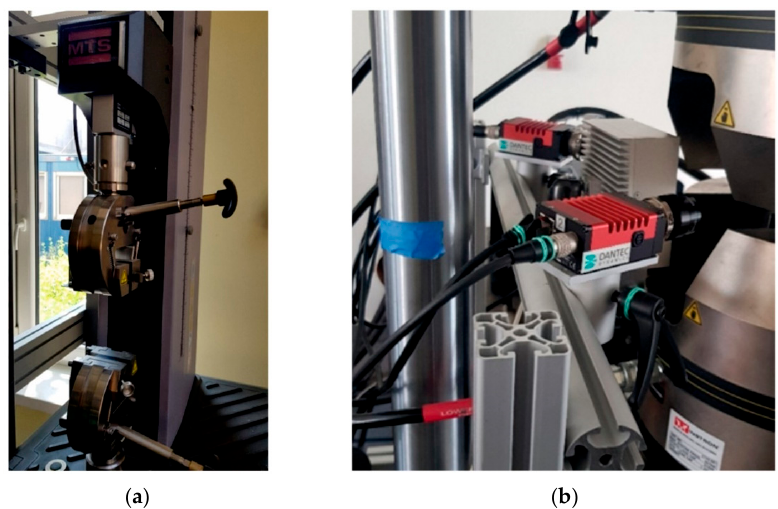
Figure 2. ( a ) MTS Criterion C; ( b ) Dantec devices used for the DIC process.